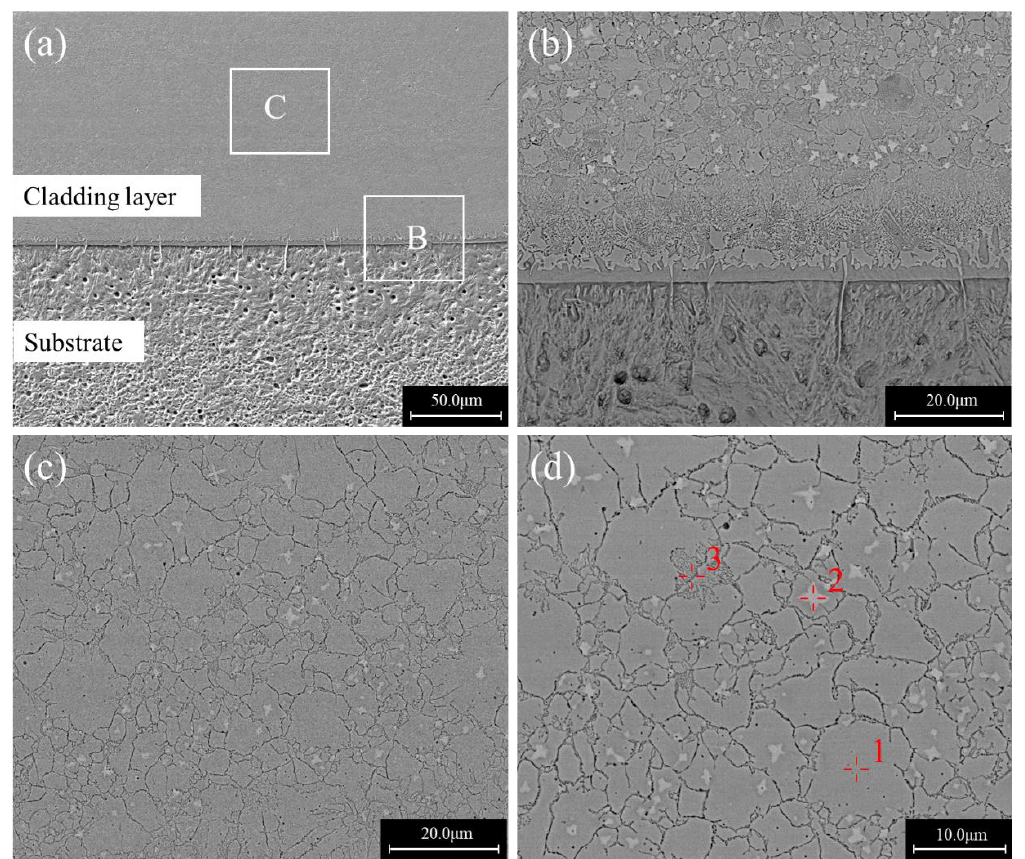
Figure 4. Cross sectional morphologies of a single-bead cladded specimen produced at the scanning speed of 8 mm/s: ( a ) Overall view; ( b ) an enlarged view of region B in ( a ); ( c ) an enlarged view of region C in ( a ); ( d ) an enlarged view of ( c ).